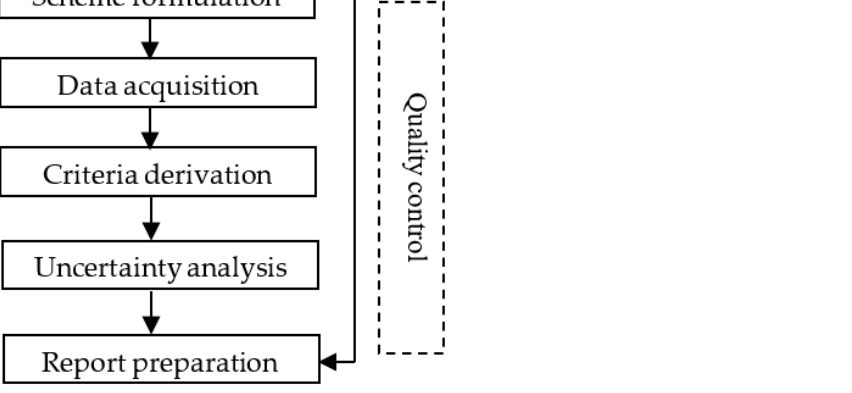
Figure 1. Development procedure of the freshwater WQC.